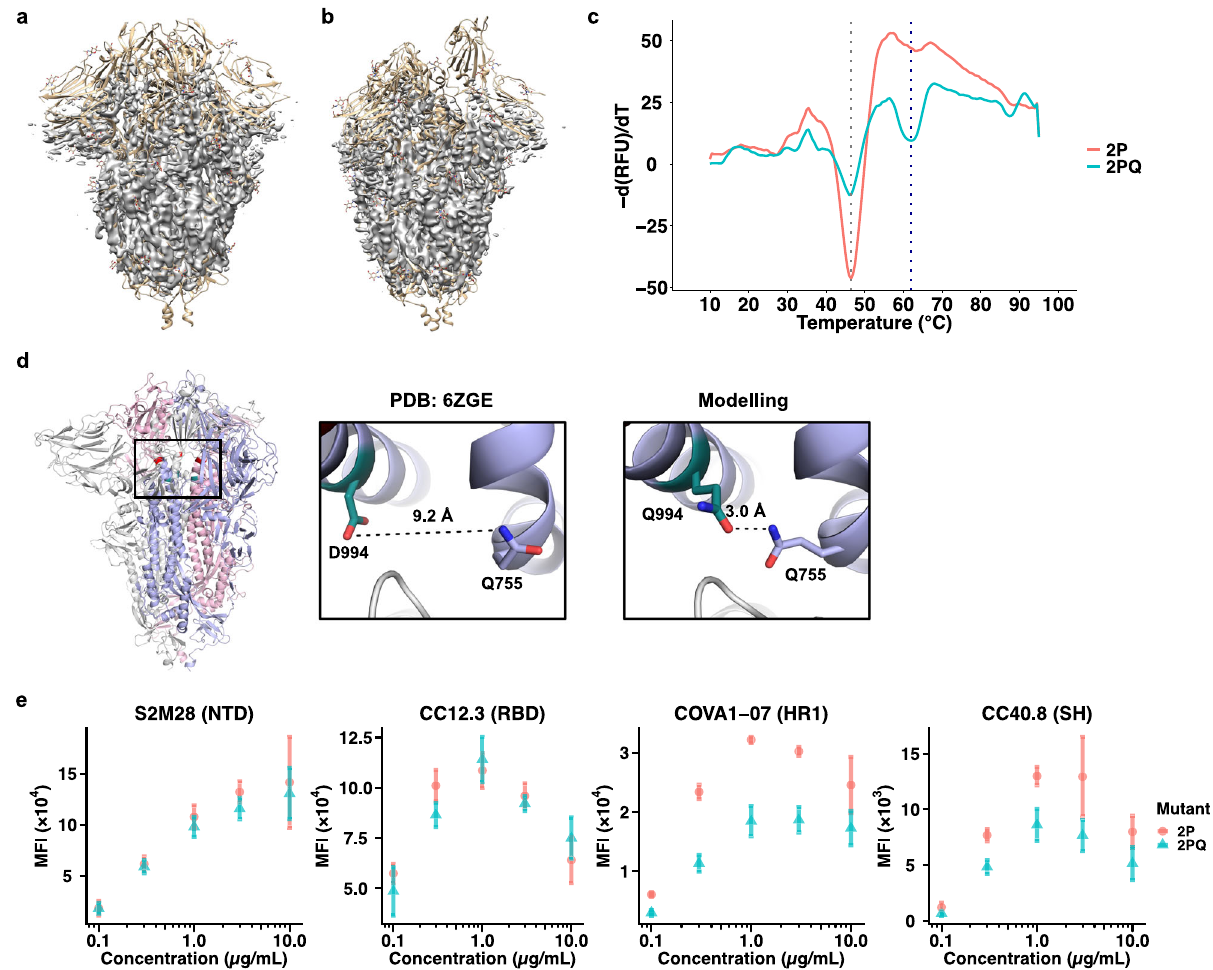
Fig. 4 | Biophysical characterization of 2PQ spike. a , b EM density map (colored grey) of 2PQ fi tted on S with all-down RBD (PDB: 6VXX) ( a ), and one-up RBD (PDB: 6VYB) ( b ). c The fi rst differential curves for the relative fl uorescence unit (RFU) from differential scanning fl uorimetry with respect to temperature are shown for soluble 2PQ and 2P. Grey dotted line indicates the fi rst apparent melting tem- perature(T m )of2Pand2PQatapproximately46.5°C;bluedottedlineindicatesthe second apparent T m of 2PQ at approximately 62°C. d D994Q allows formation of an additional intraprotomer hydrogen bond as shown by structural modelling.